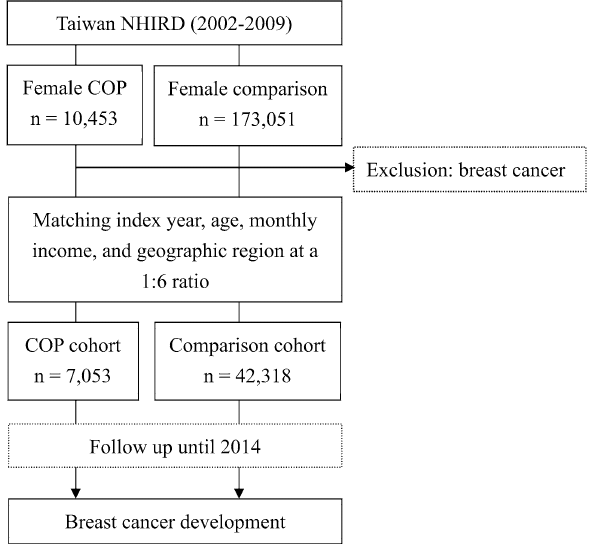
Figure 1. Flowchart of the present study. NHIRD National Health Insurance Research Database, COP carbon monoxide